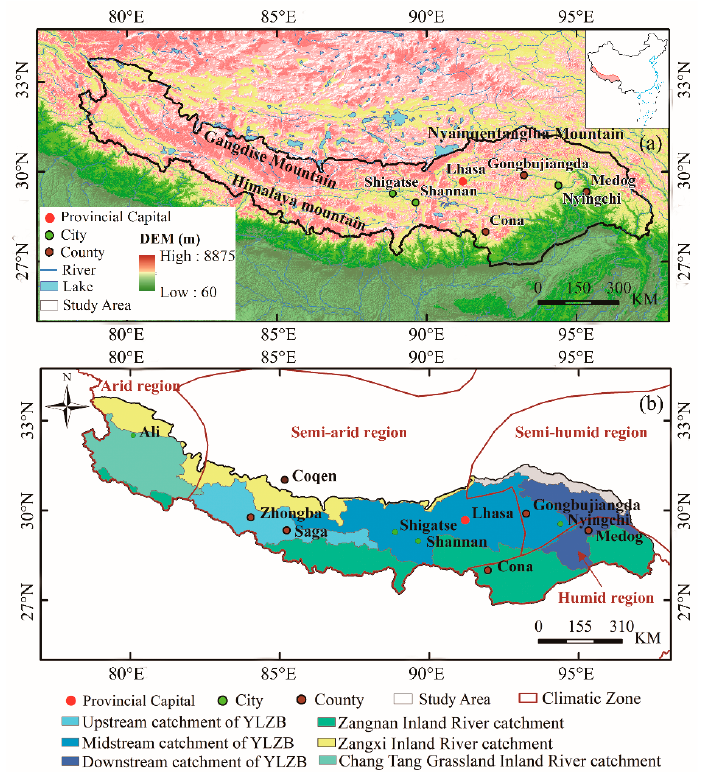
Figure 1. ( a ) Location of the Himalayas extra-high mountain region (HEM) region in China; ( b ) geographical distribution of the climate zones and three-level catchments over the HEM region.